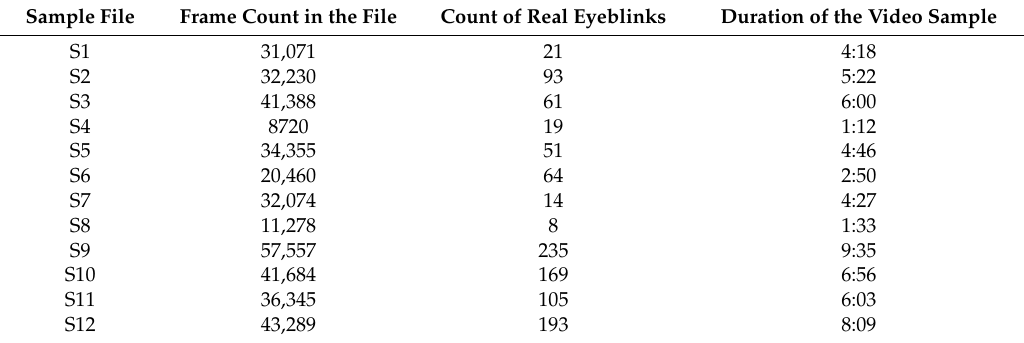
Table 5. Frame count, the total number of actual eyeblinks in each sample and duration (in